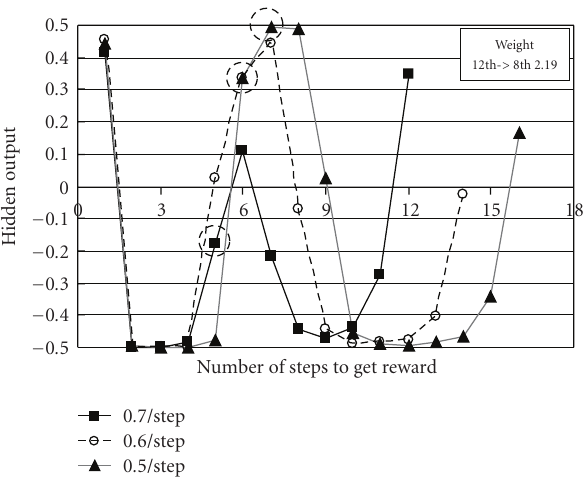
Figure 13: Output change of the 12th hidden neuron for the three velocities. Broken circles indicate the timing just before the object disappears.